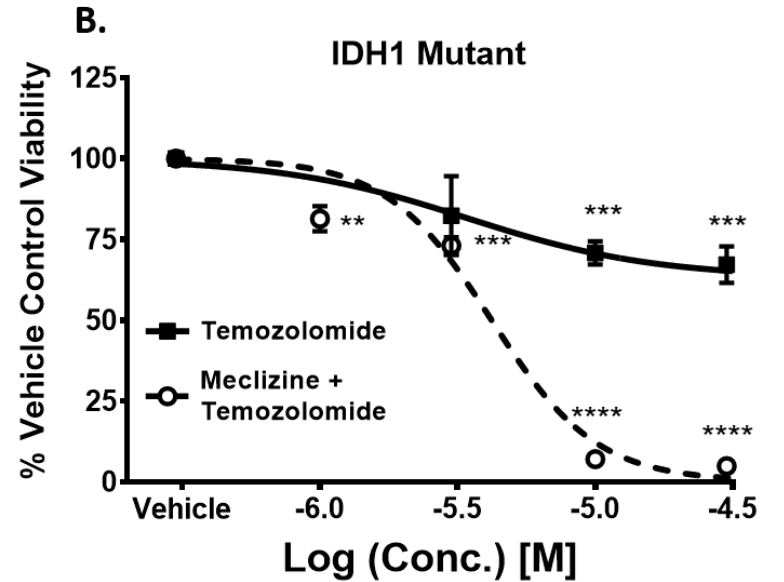
Figure A1. Coadministration of temozolomide and meclizine is more toxic than temozolomide alone. ( A ) Temozolomide and meclizine co-administered with temozolomide, the current standard of care, in a subsequent GBM IDH1 wildtype cell line and a ( B ) IDH1 mutant World Health Organization (WHO)-grade III astrocytoma. Experiments were conducted using Trypan Blue Exclusion in patient-derived GBMsc. Experimental points are an average of 3 experiments. Error bars are the standard error of the mean. The curve is a 3-parameter-model sigmoidal dose–response curve. The X-axis is drug concentration, while the Y-axis is % viability of GBMsc normalized to vehicle control. * p < 0.05, ** p < 0.01, *** p < 0.001, **** p < 0.0001.